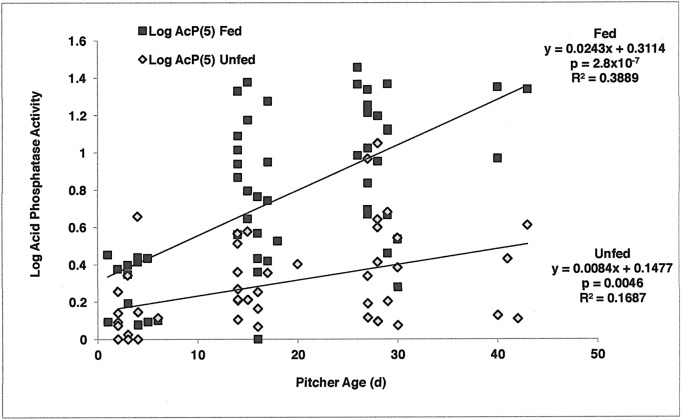
Regression analysis of log acid phosphatase activity across pitcher age (d) for fed and unfed pitchers.Both fed and unfed pitchers exhibited an increase in acid phosphatase activity with increasing pitcher age, with a greater increase in the fed pitchers. Pitcher age accounted for almost 39% of variation in enzyme activity in fed pitchers and just under 17% of the variation in enzyme activity in unfed pitchers.